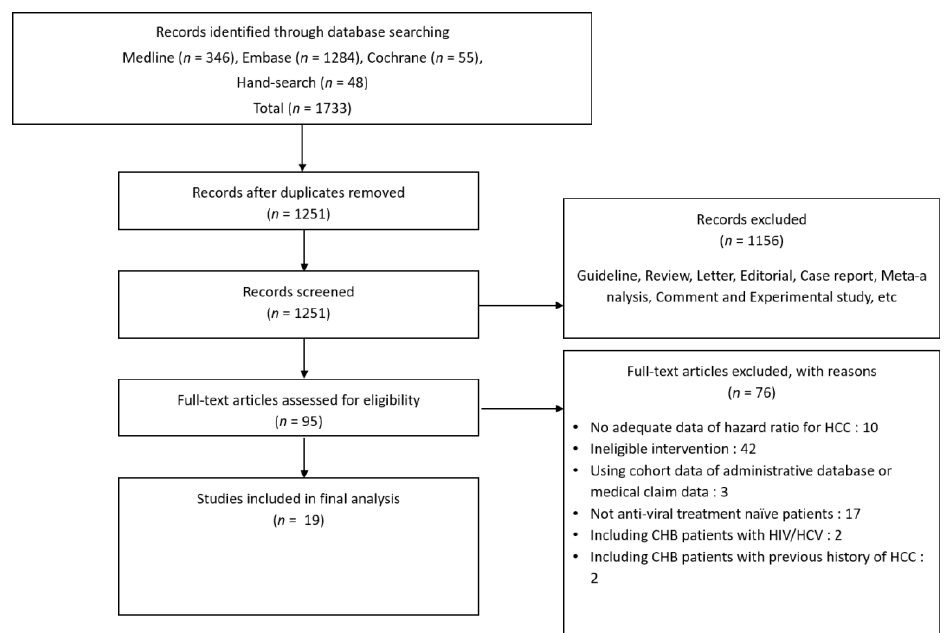
Figure 1. Flow diagram showing the literature search (31 August 2021 record).